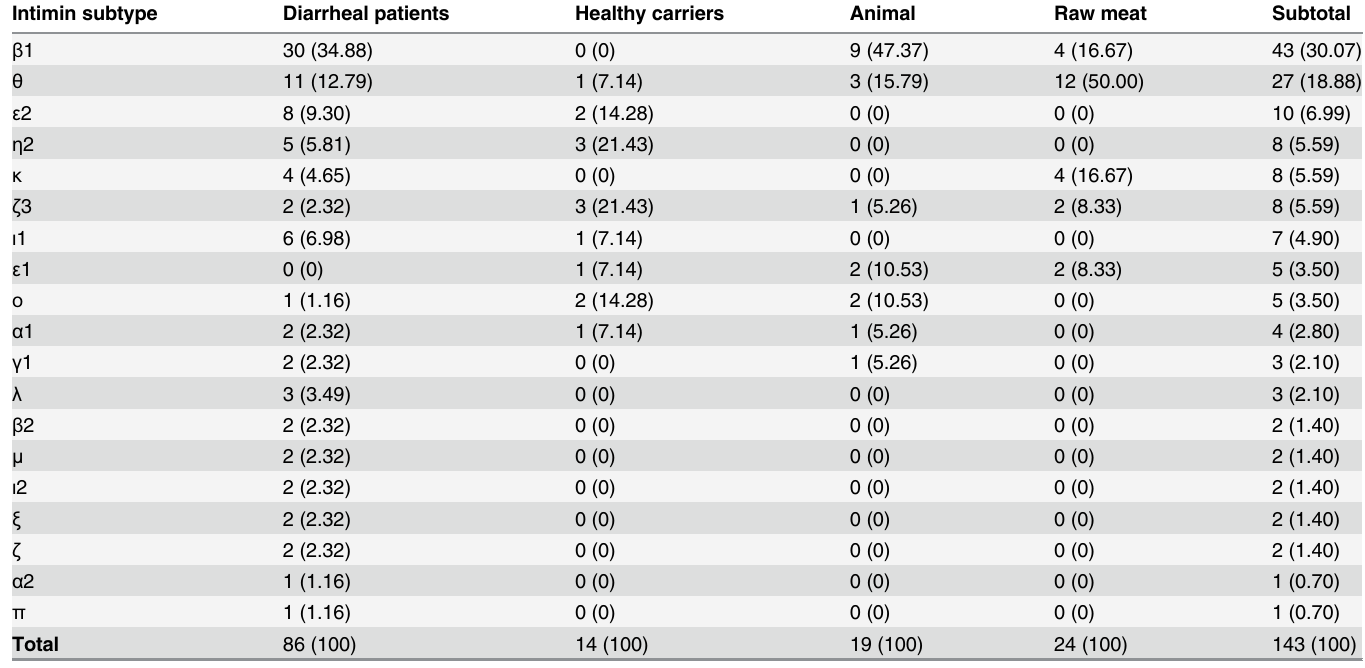
Table 1. Intimin subtypes of atypical EPEC strains isolated from diarrheal patients, healthy carriers, animals, and raw meats a